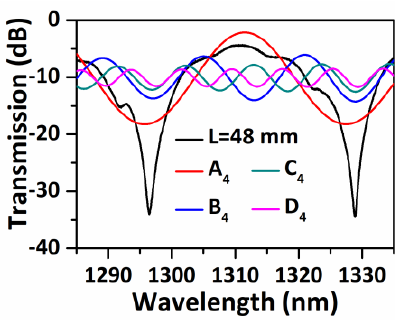
Figure 5. Measured spectral responses of S-48 and fast Fourier transform (FFT) band pass filter recovered transmission spectra corresponding to different frequencies of A 4 , B 4 , C 4 , D 4 .